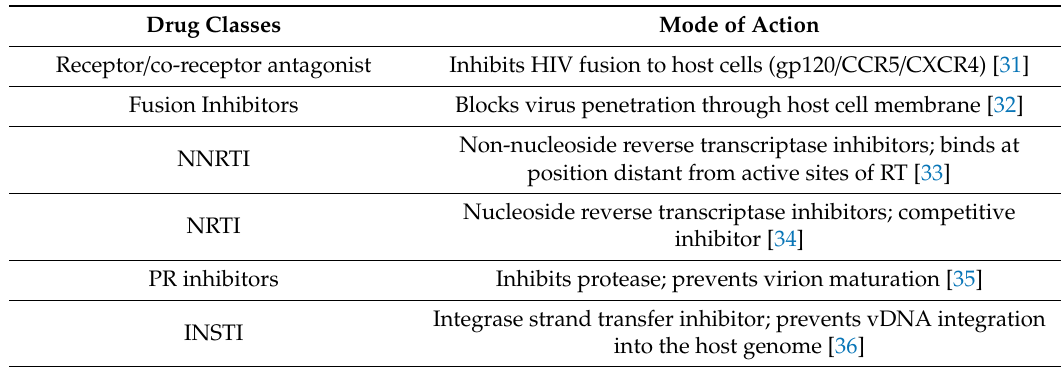
* Table modified from reference